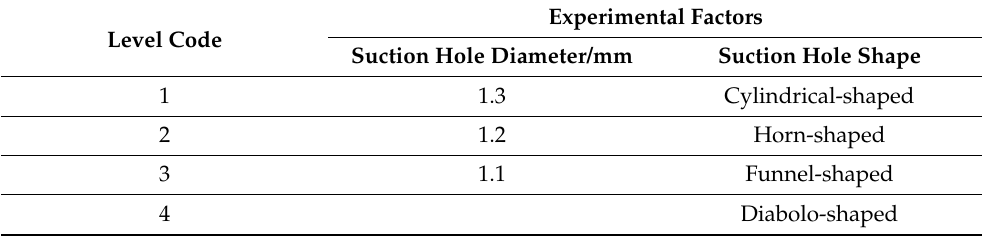
Table 1. Experimental factors and level codes of single-factor experiments.